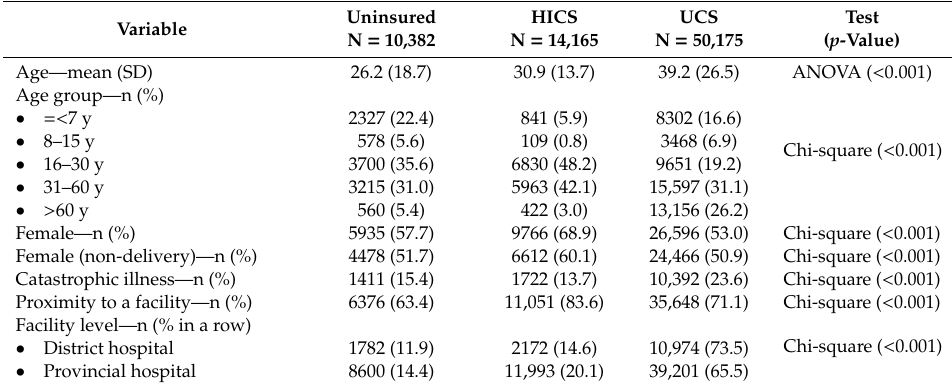
Table 1. Comparing total admissions by personal attributes and insurance schemes.